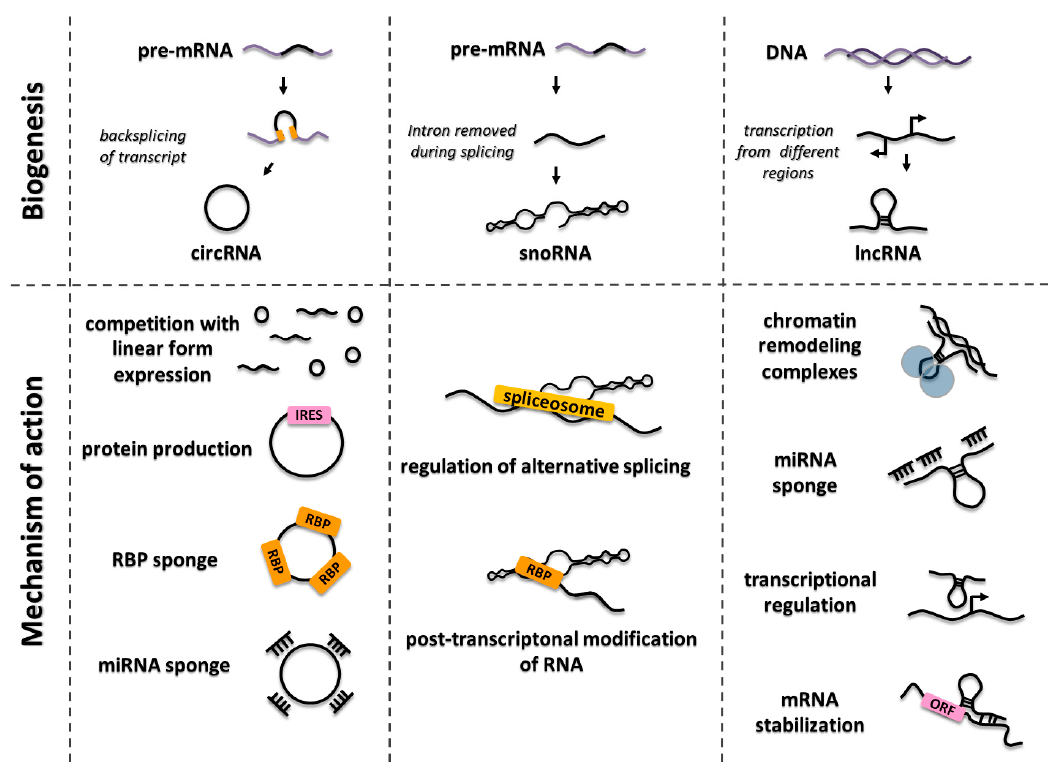
Figure 2. The principal functions of long non-coding RNAs (lncRNAs), circular RNAs (circRNAs), and small nucleolar RNAs (snoRNAs).